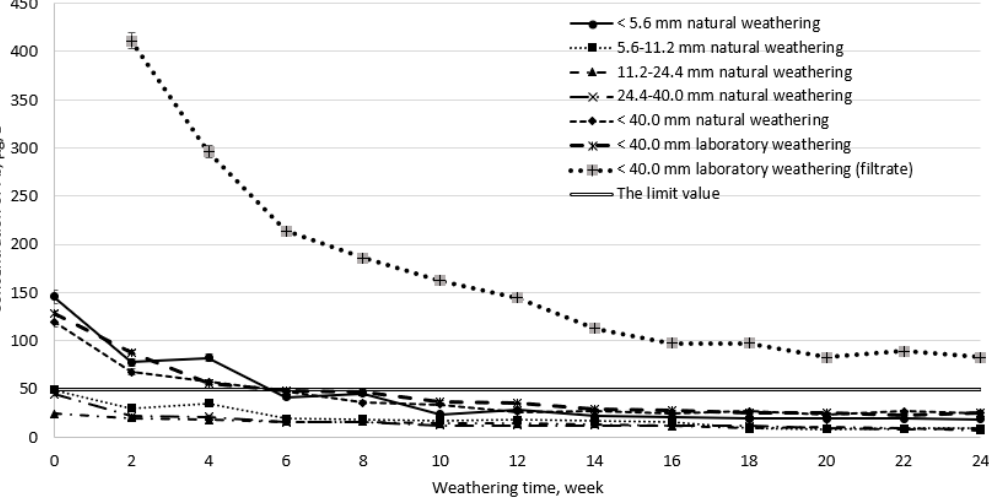
Figure 10. Concentration of lead (Pb) in different fractions of bottom ash eluate and leachate during natural weathering and laboratory aging.